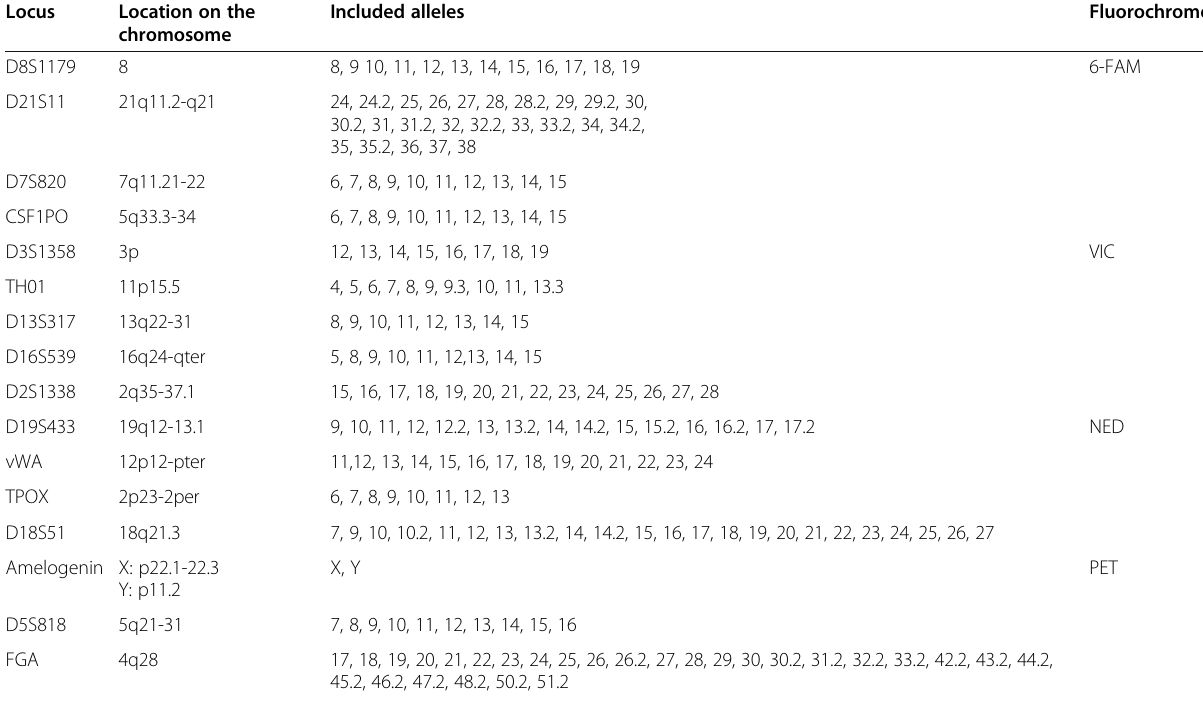
Table 1 16 STR loci and alleles with their characteristics Locus Location on the Included alleles chromosome